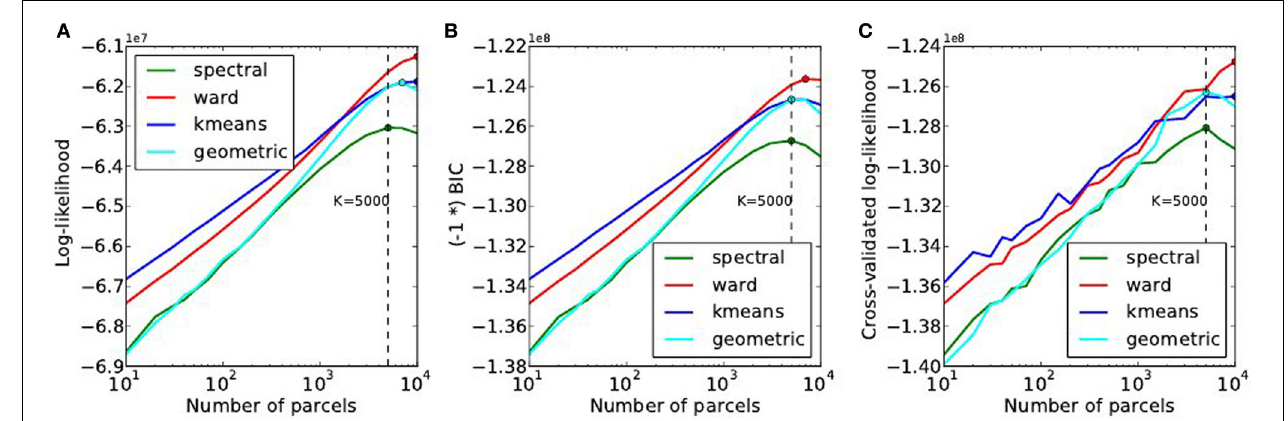
FIGURE 6 | Distortion metrics. (A) Accuracy of the model (Equation 6) measured through the summed Log-likelihood across parcels, as a function of the number K of clusters. The accuracy is maximized for very high values of K .